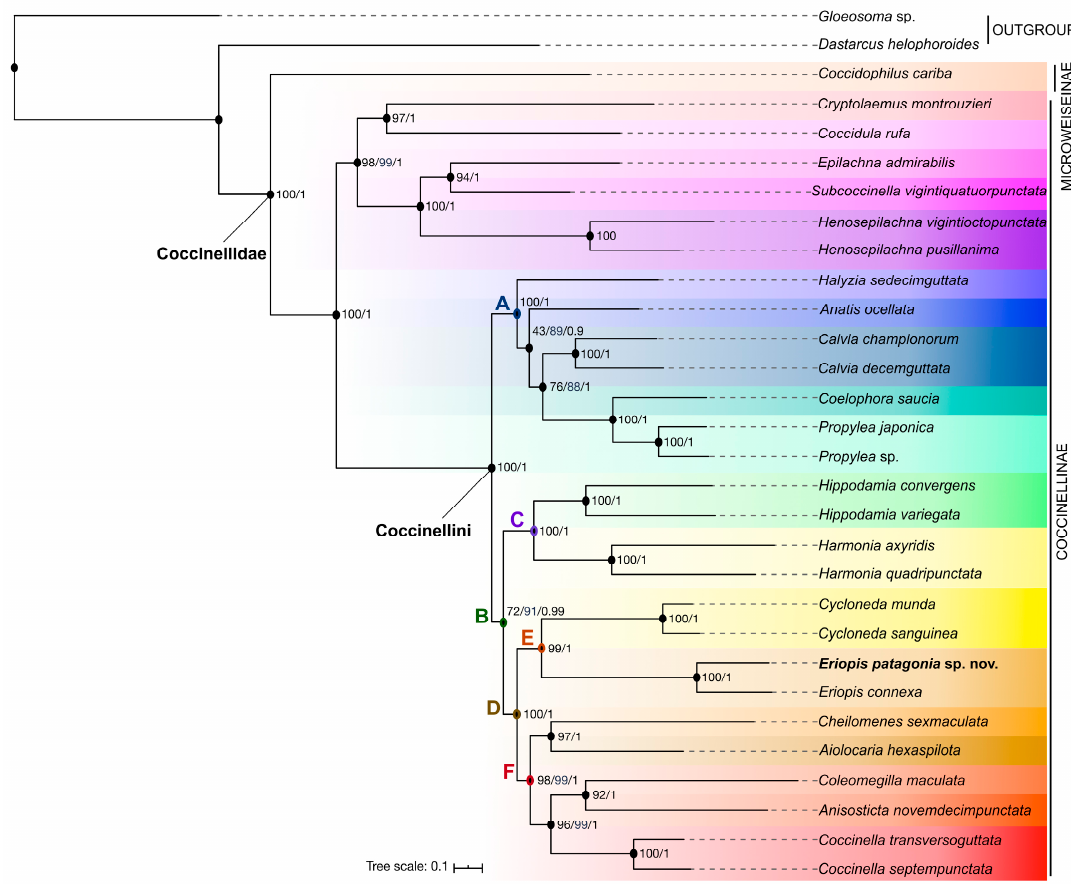
Figure 9. Phylogenetic relationships of Coccinellidae. Tree inferred by the maximum likelihood estimation method (ML) based on 13 protein-coding genes (including all codon positions) and two ribosomal RNAs from mitochondrial genomes of 28 Coccinellidae and two out-groups. ML bootstrap support and posterior probability values are indicated at the right of each node. Transfer bootstrap expectation value (blue) is only shown when it differs from the bootstrap value.